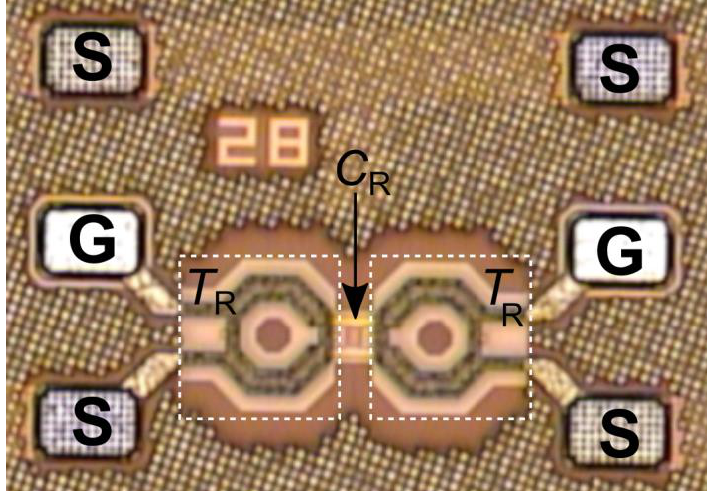
Figure 5. Ground–signal–ground (GSG) structure for on-wafer measurements of transformer T R .